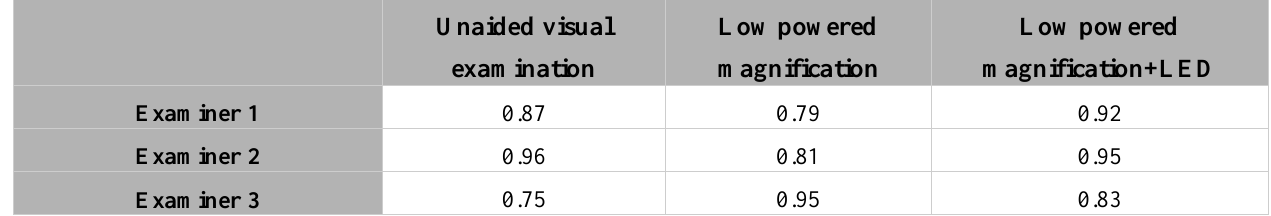
Table 4. Intraexaminer reproducibility of ICDAS examinations (Weighted Kappa) for Permanent molars.